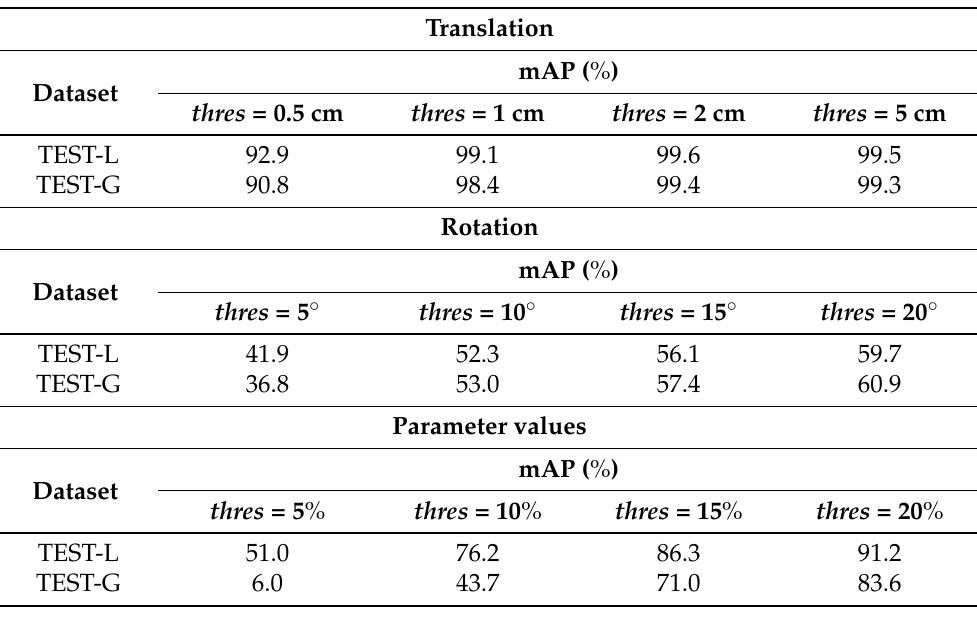
Table 3. Learning and generalization ability evaluation on the Multi-Parametric